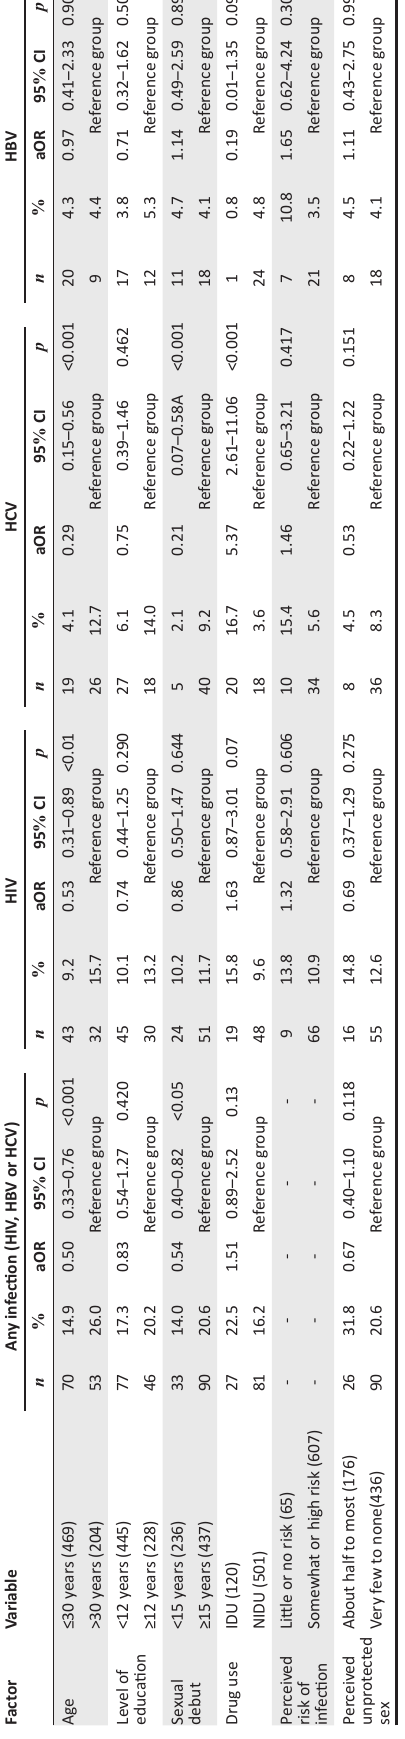
TABLE 4: Distribution of hepatitis B virus subgenotypes among drug users from three major cities in Kenya. Participant Gender Age Area Nested BCP ID. No (years) (town) PCR